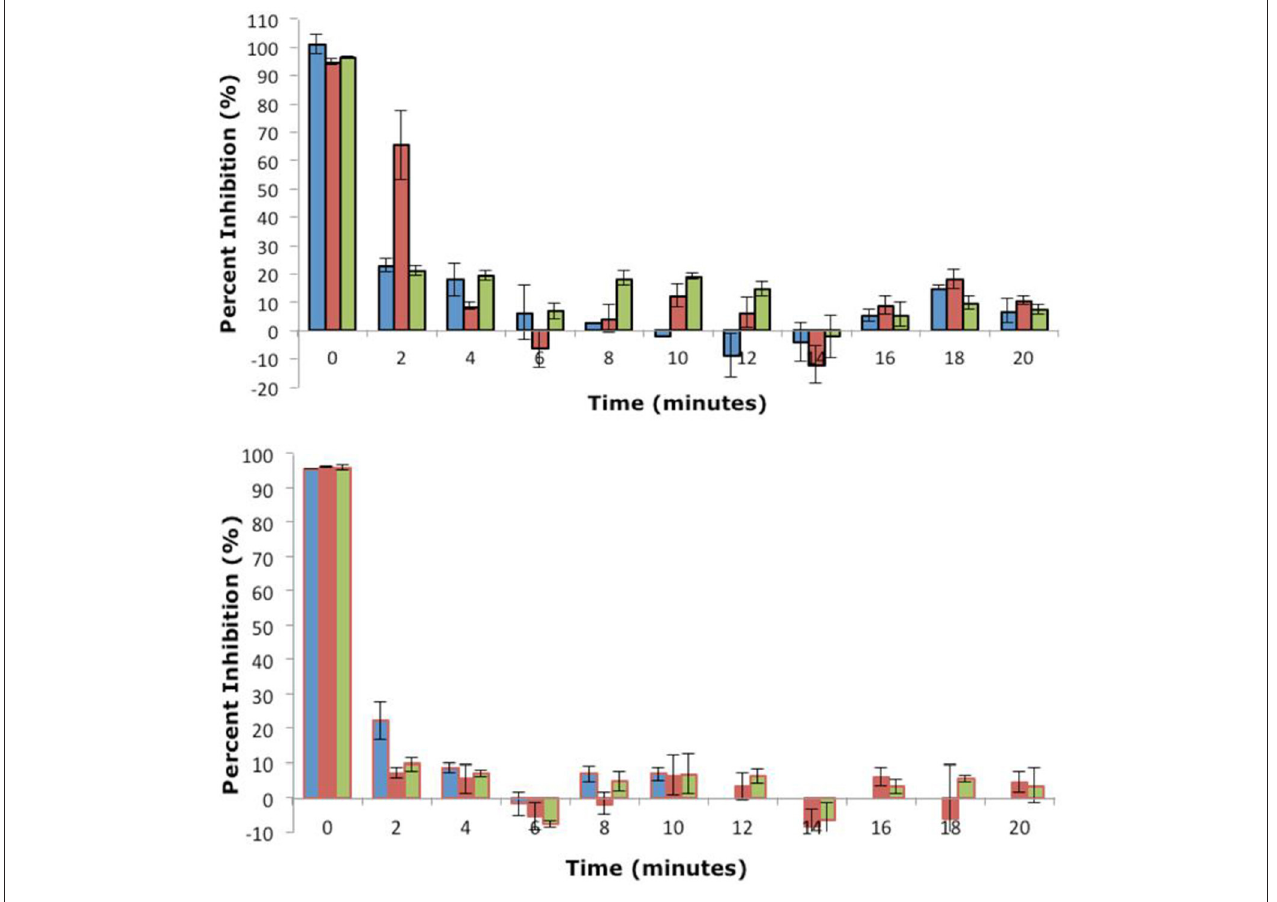
FIGURE 5 | Inhibition of MC ozonolysis products against protein Phosphatase 1 after treatment at an air flow 1L min − 1 (0.199 ppm O 3